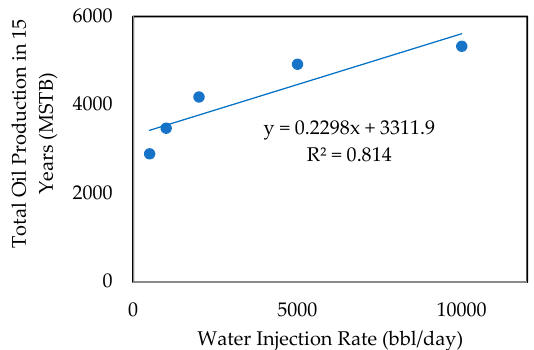
Figure 11. Variation of oil production with water injection rate (WAG).